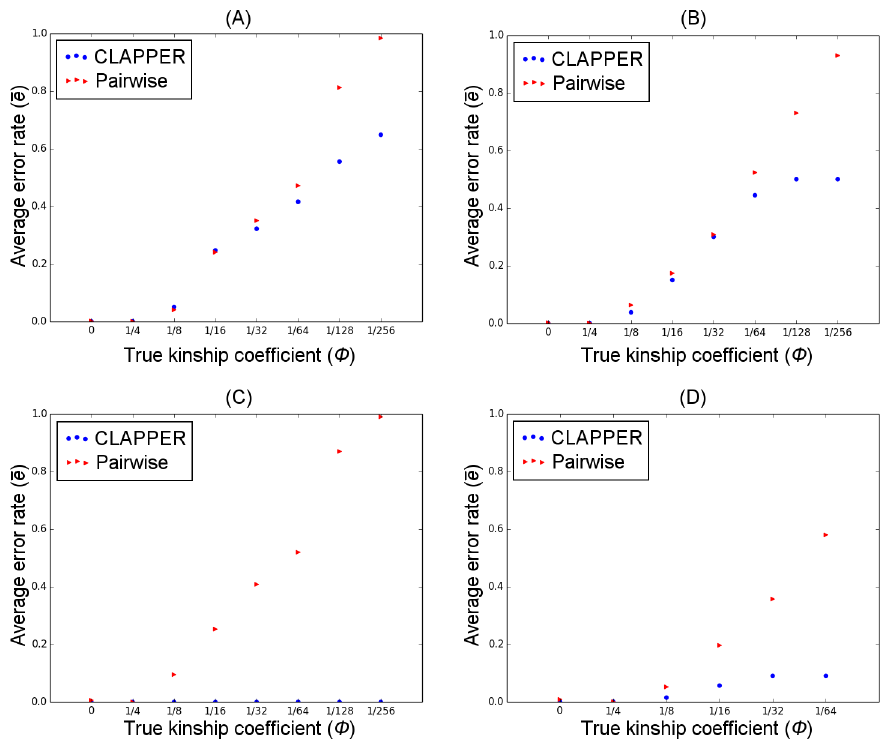
scenario:(A) simulationA; (B) simulationB; (C) simulationC; (D) simulationD.